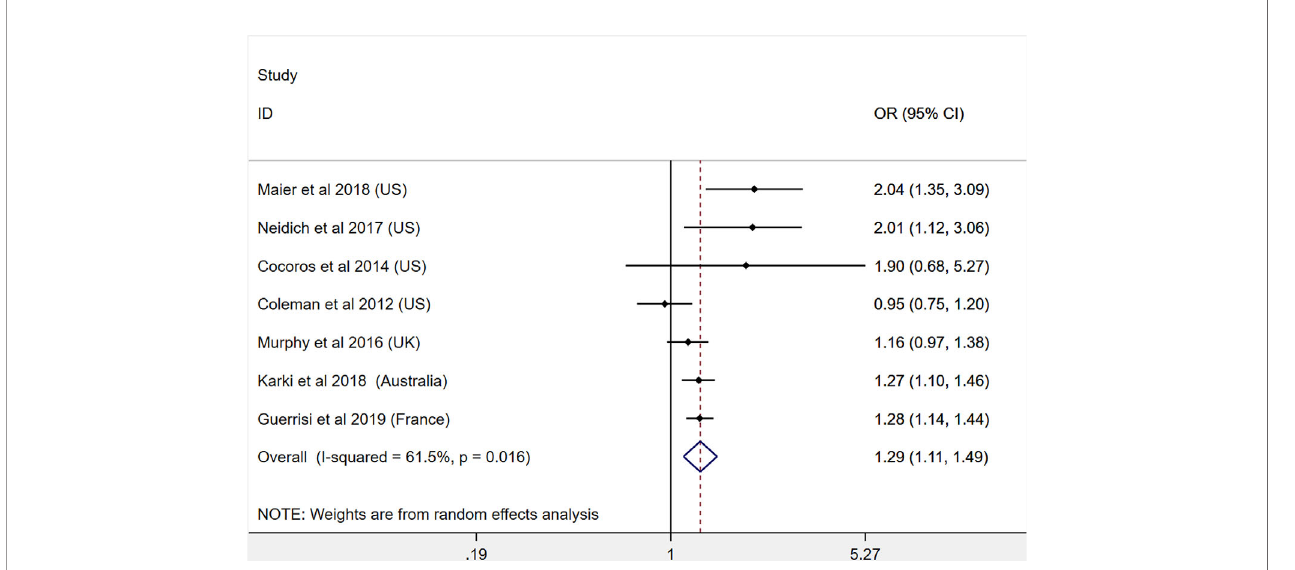
FIGURE 2 | Odds ratios for in fl uenza infection in patients with obesity versus patients without